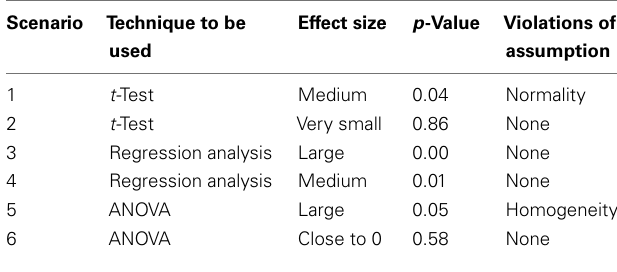
Table 1 |An overview of the properties of the six scenarios.